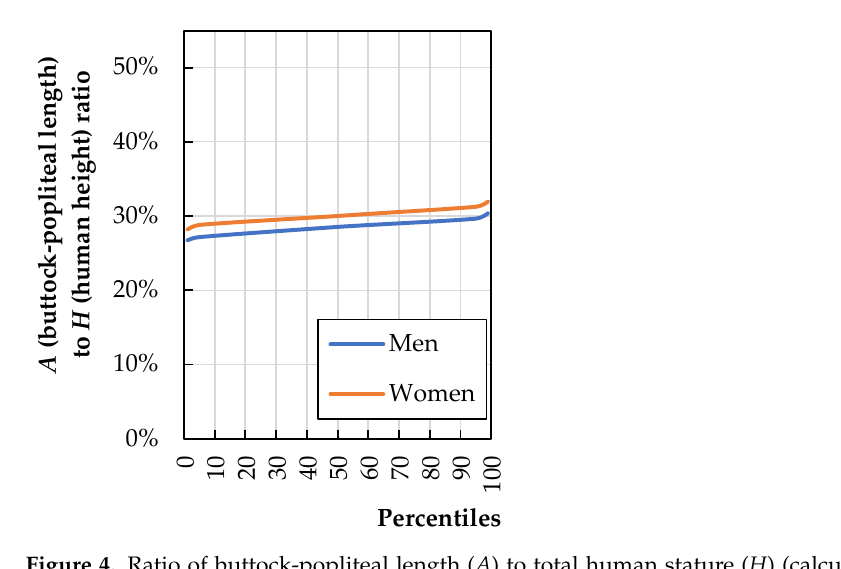
Figure 4. Ratio of buttock-popliteal length ( A ) to total human stature ( H ) (calculations based on literature data [20]).